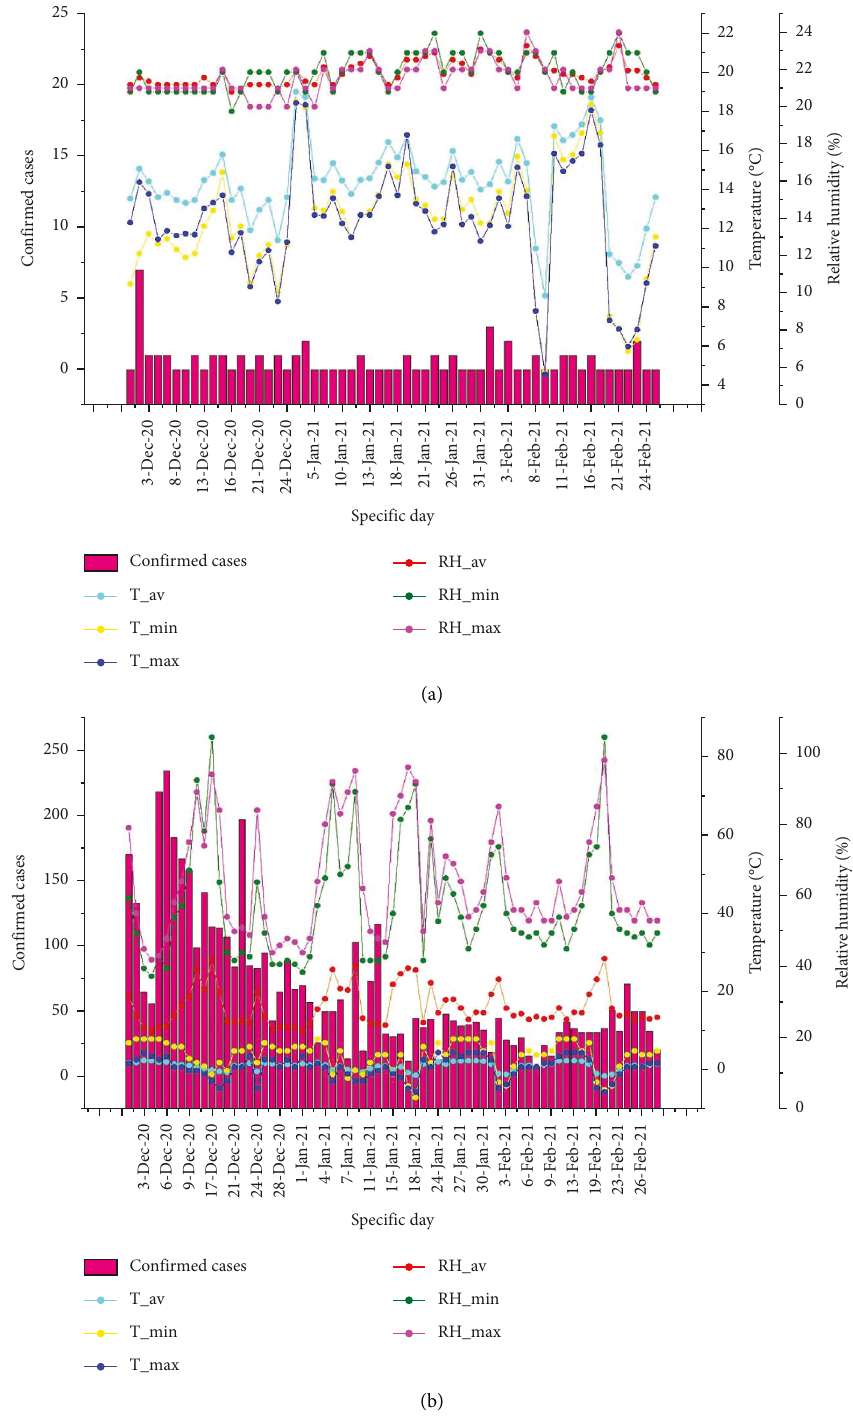
Figure 1: Total confirmed COVID-19 cases and environmental variables before starting the vaccination process in KRI for (a) indoor configuration and (b) outdoor